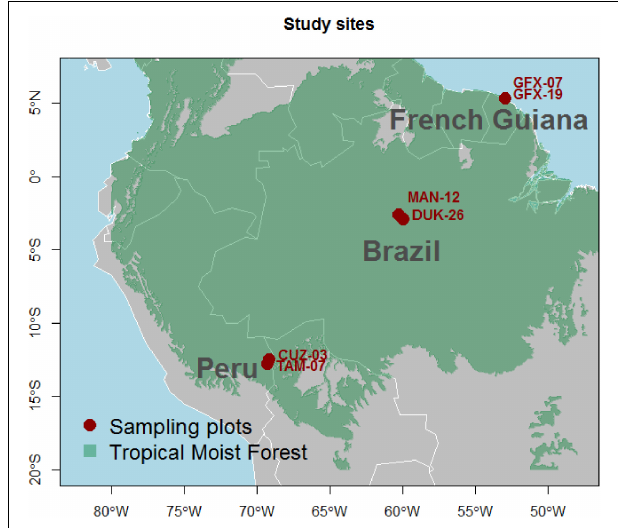
FIGURE 1 | Location of the six sampling